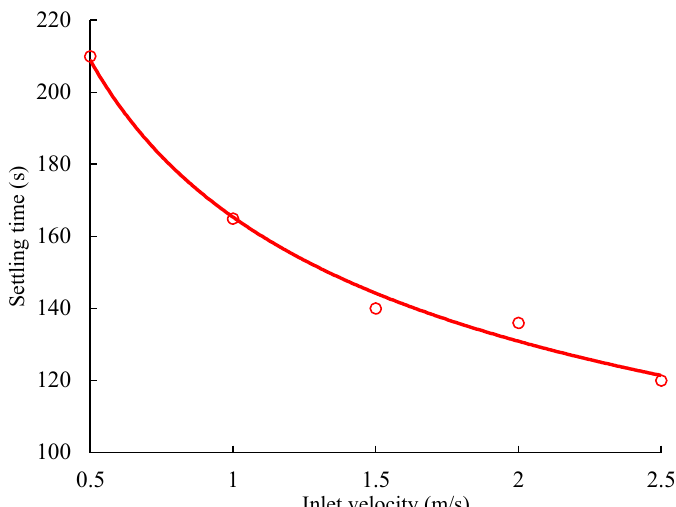
Figure 7. Gravel settlement diagram with different fluid velocity.